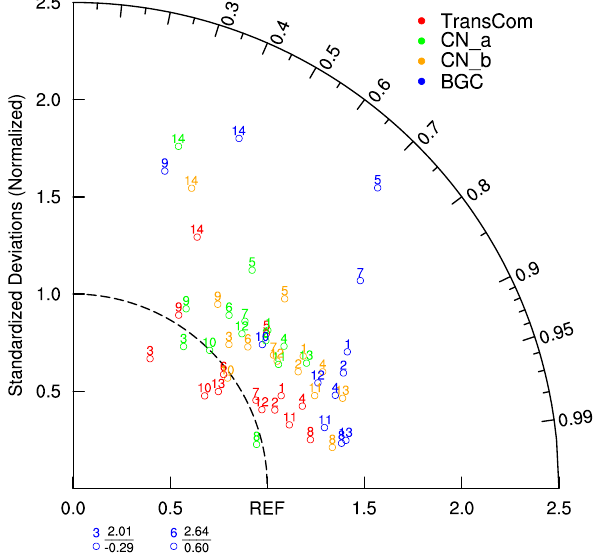
Figure 12. Taylor diagrams comparing the model interannual vari- ability to methane observations at 14 stations. In this Taylor dia- gram, the angle from the x axis is the correlation coefficient be- tween model and observed time series of atmospheric CH 4 concen- tration. The value on the radial axis is the standard deviation ratio: σ model /σ obs . It represents the match between the amplitude of the model and observed interannual variability. Please refer to Table 2 for the stations associated with each number.